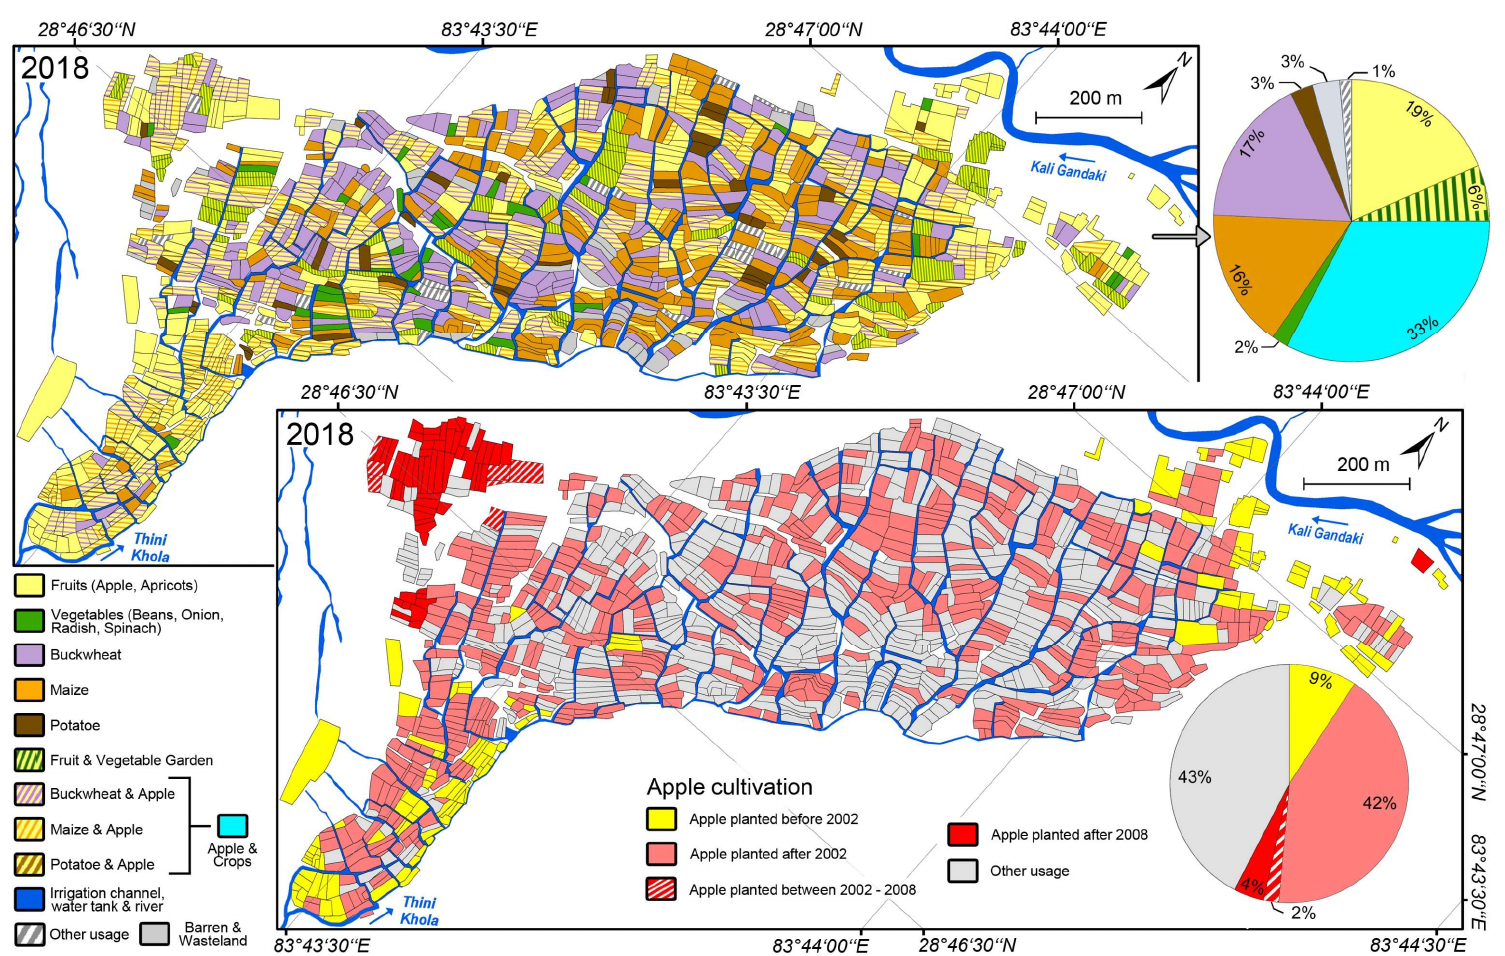
Figure 9. Land use at Jomsom settlement during the autumn season in 2018 (upper graph) and historical development of apple cultivation (lower graph). Pie charts represent the relative area of the various crops in relation to the total arable land. The intercropping of apples with buckwheat, maize, and potatoes are grouped as cyan within the pie chart. The underlying detailed on-site mapping was performed in October 2018. Projection WGS 1984 UTM Zone 44N (scale 1:12,000).